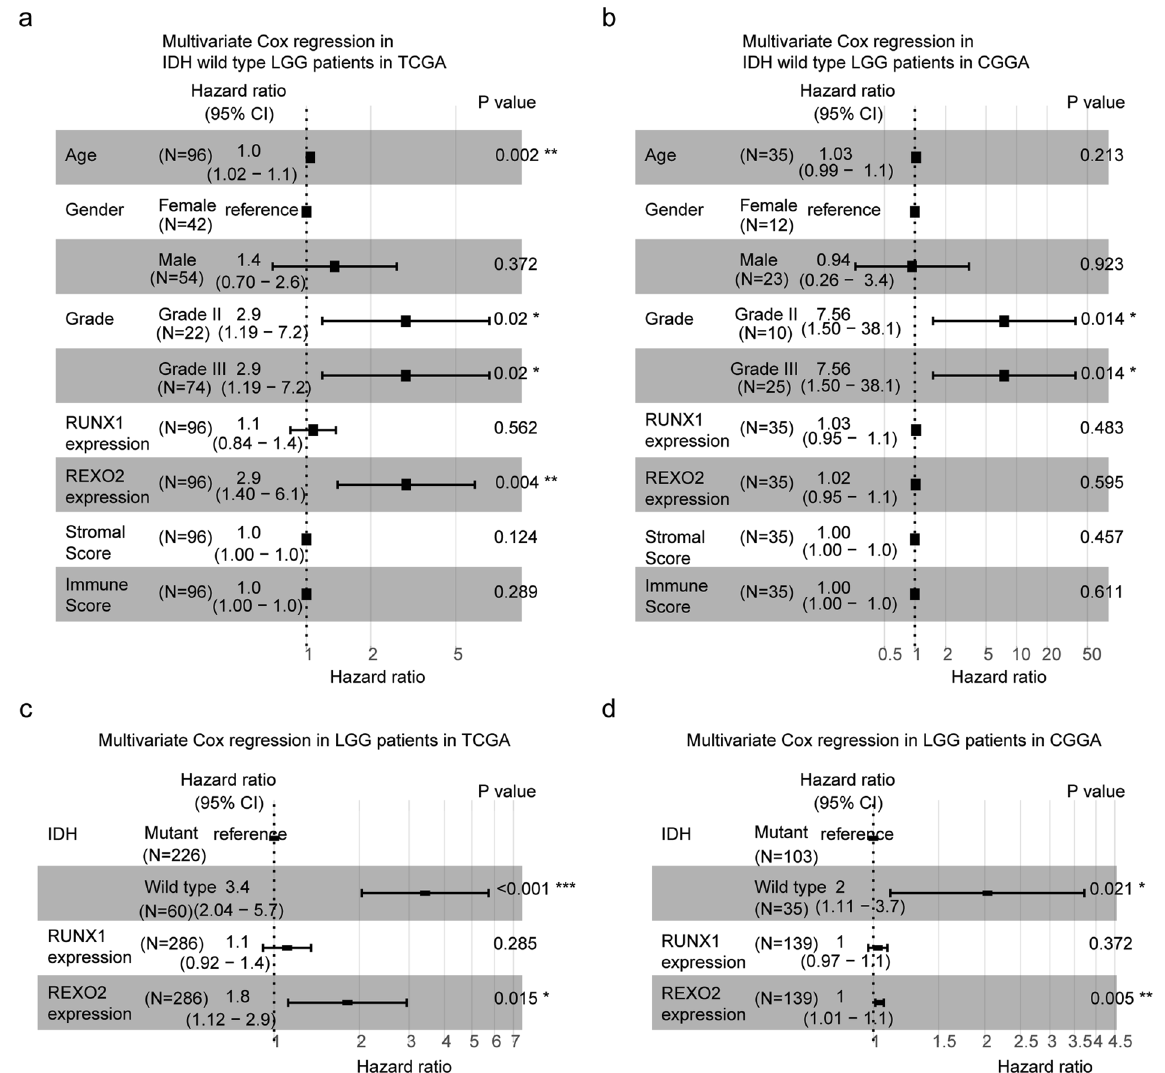
Figure 8. Age, tumor grade and REXO2 expression are independent prognostic factors in IDH wild type LGG patients. ( a ) Forest plot showed the correlations of age, gender, tumor grade, RUNX1 expression, REXO2 expression, stromal score, immune score with the clinical overall survival of IDH wild type LGG patients in TCGA dataset, determined by multivariate cox regression. ( b ) Forest plot showed the correlations of age, gender, tumor grade, RUNX1 expression, REXO2 expression, stromal score, immune score with the clinical overall survival of IDH wild type LGG patients in CGGA dataset. ( c ) Multivariate cox regression analysis determined the prognostic effects of IDH alteration, RUNX1 expression and REXO2 expression in LGG patients in TCGA dataset. ( d ) Multivariate cox regression analysis the prognostic effects of IDH alteration, RUNX1 expression and REXO2 expression in LGG patients in CGGA